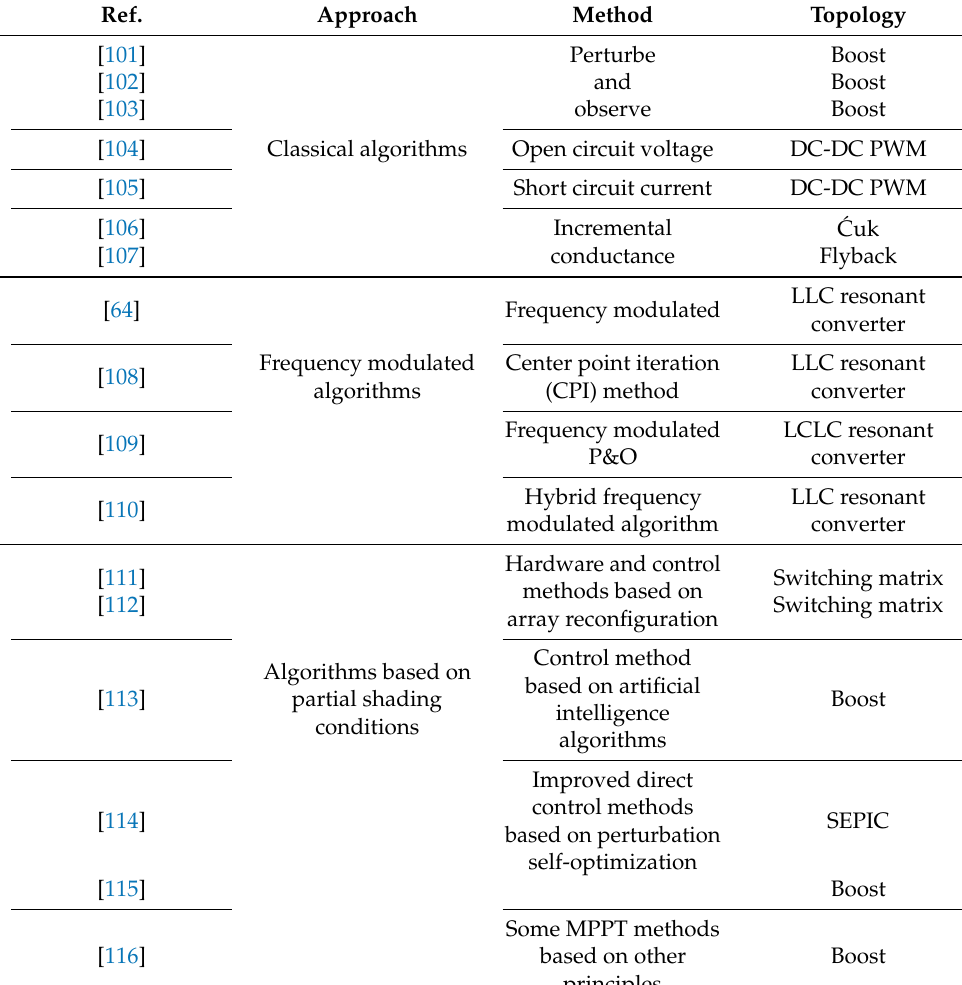
Table 7. MPPT algorithms for PV-connected